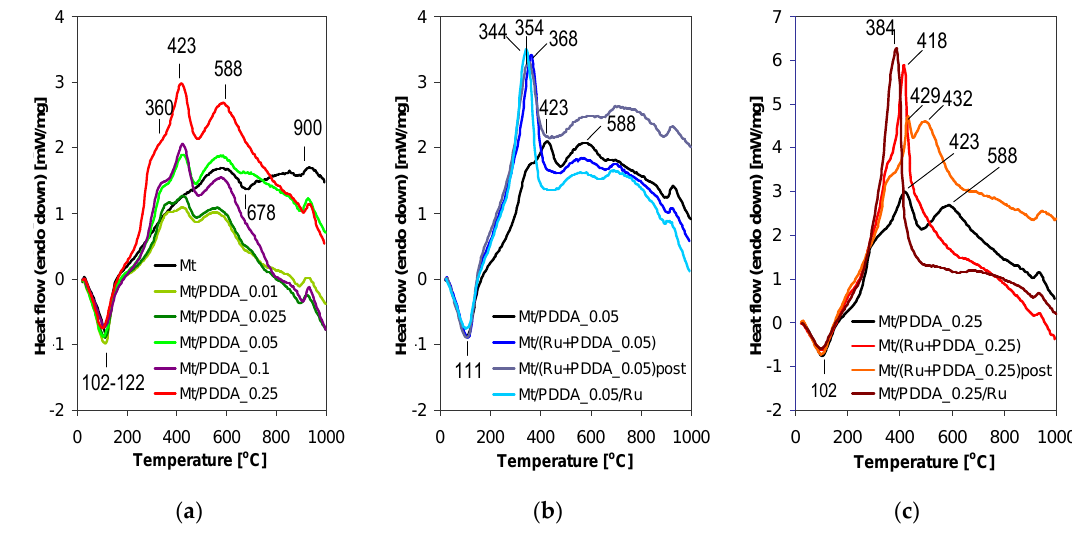
Figure 7. DSC profiles of: ( a ) PDDA-intercalated montmorillonites; ( b ) composites with PDDA/clay weight ratio of 0.05; ( c ) composites with PDDA/clay weight ratio of 0.25.